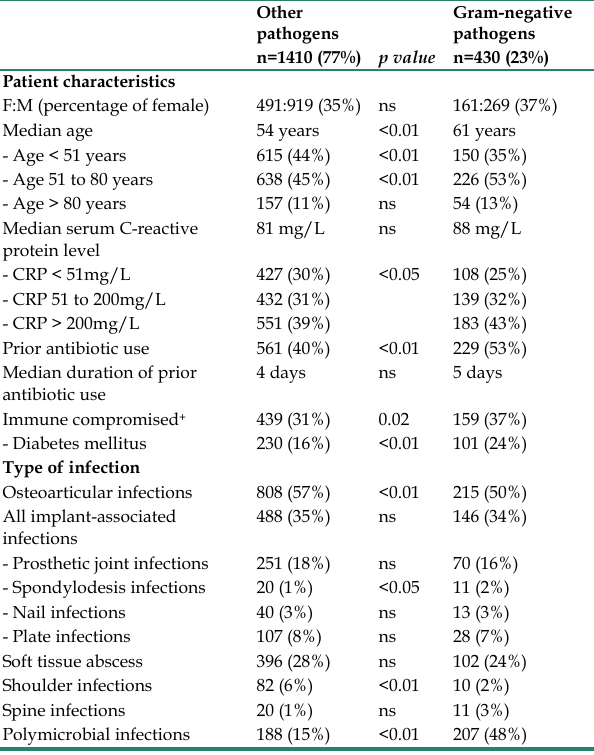
Table 1 . Comparison of orthopedic infections due to Gram- negative versus other pathogens at Geneva University Hospitals, 2004-2014. Other